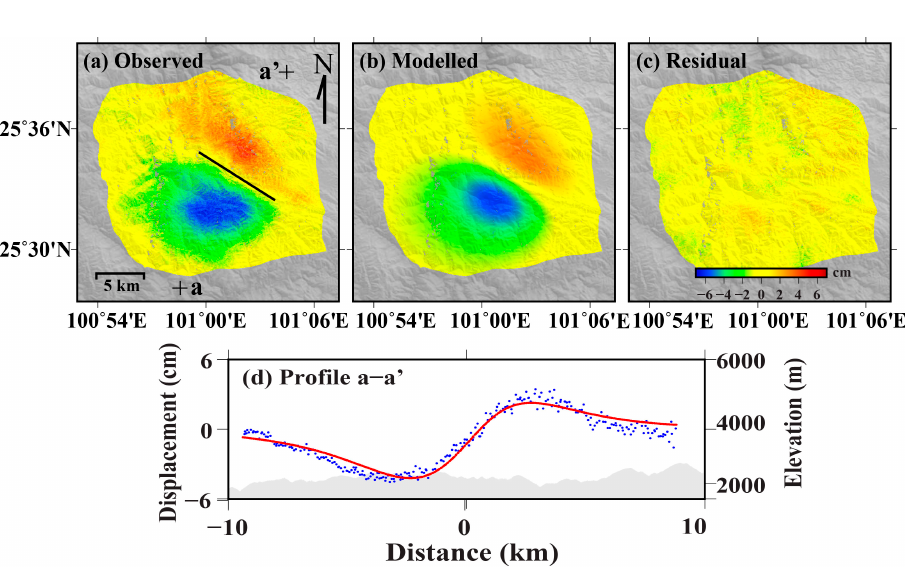
Figure 3. Coseismic deformation and model for uniform slip inversion of the Yao’an earthquake; ( a ) Observed coseismic interferogram (the black line represents the modeled fault trace); ( b ) model synthetic interferogram; ( c ) residual interferogram between observation and modeling; ( d ) a–a’ is a profile across the fault trace and the profile of line-of-sight (LOS) displacement (blue dots), model LOS displacement (red dots) and topography (grey).